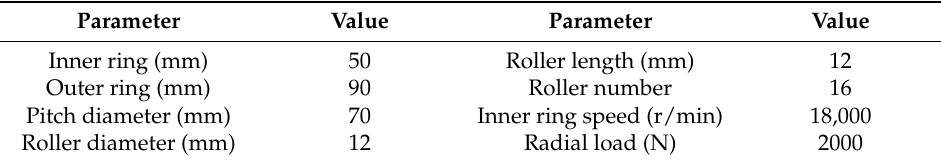
Table 1. Geometry parameters of the roller bearing.